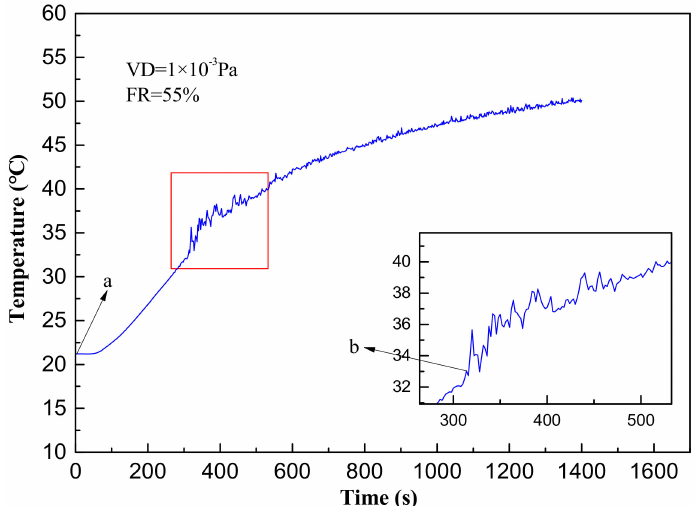
Figure 5. The variation of temperature on evaporation section of PGHP with heating time at 120 W. FR denotes working fluid filling ratio, VD denotes vacuum degree. Points a and b denote the positions of beginning heating time and start-up time,